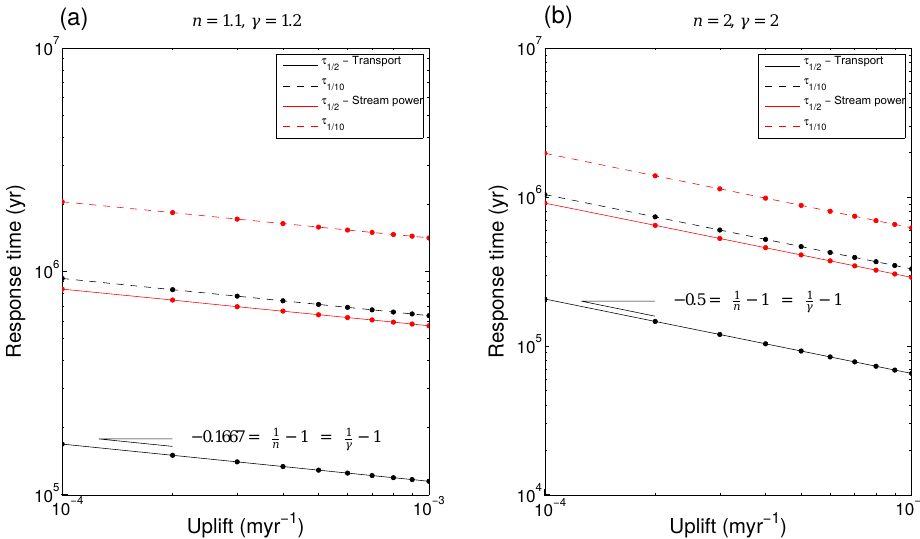
Figure 13. Log–log plot of response time for different slope exponents and uplift rates to a change to a precipitation rate from an initial value of α 0 = 1 to α 1 = 0 . 5myr − 1 ; τ 1 / 2 is the time for the sediment flux to recover by half of the magnitude change in sediment flux and τ 1 / 10 is the time for the sediment flux to recover by 90%. (a) Response time for the transport model (Eq. 8) and stream power model (Eq. 12) when the slope exponent γ = 1 . 2 and n = 1 . 2, respectively. A linear trend is found with a gradient of − 1.667. (b) Response time for the transport model and stream power model when the slope exponent γ = 2 and n = 2, respectively. A linear trend is found with a gradient of −